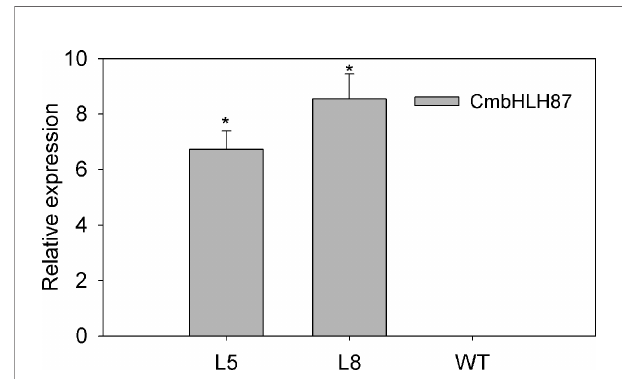
FIGURE 3 | Relative expression of CmbHLH87 in transgenic or wild-type plants under normal growth conditions. L5 and L8 are two independent transgenic lines that overexpress CmbHLH87 . Three biological triplicates were averaged and bars indicate standard error of the mean. *denotes statistical signi fi cance at p < 0.05 between both materials.